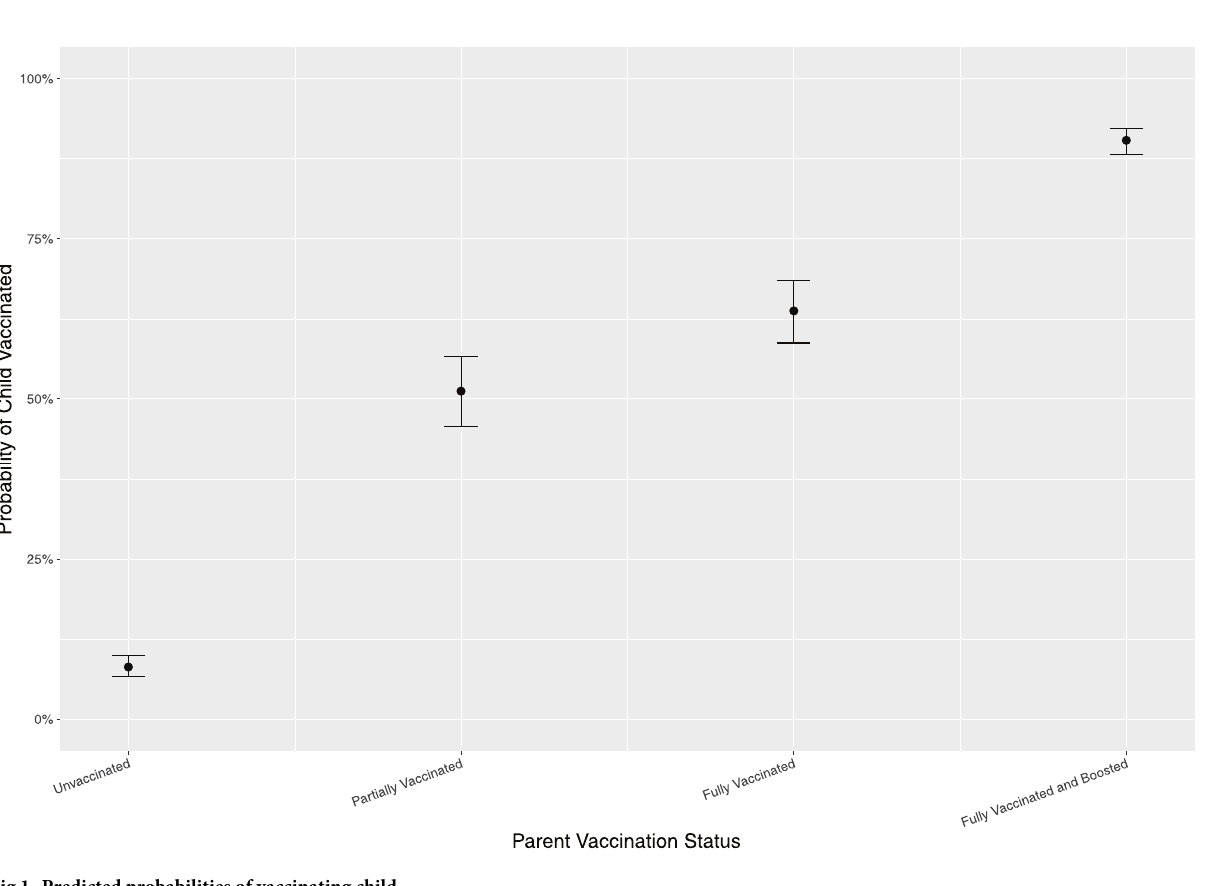
Fig 1. Predicted probabilities of vaccinating